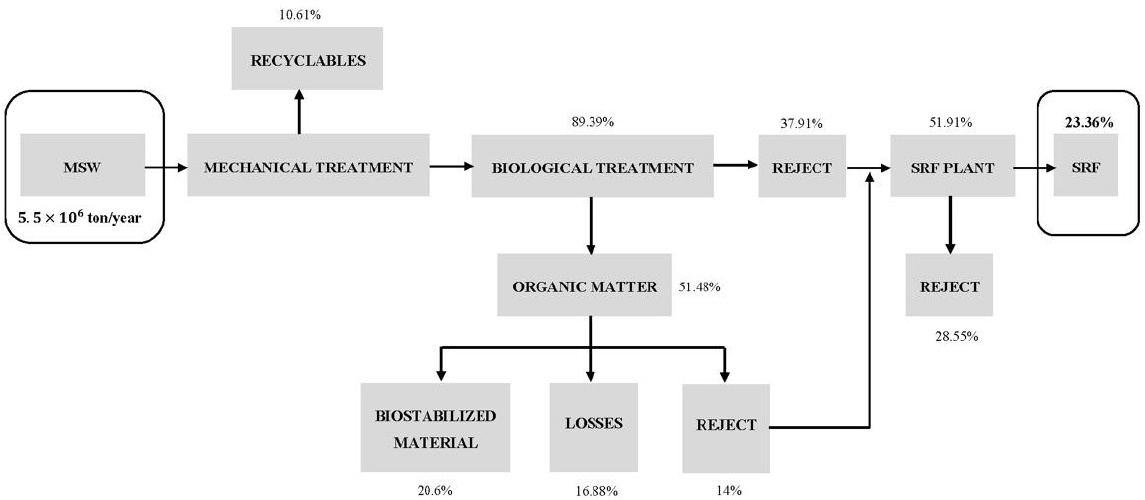
Figure 4. Flowchart of the process showing the mass balance (in % of the initial 5.5 × 10 6 ton/year) [68].